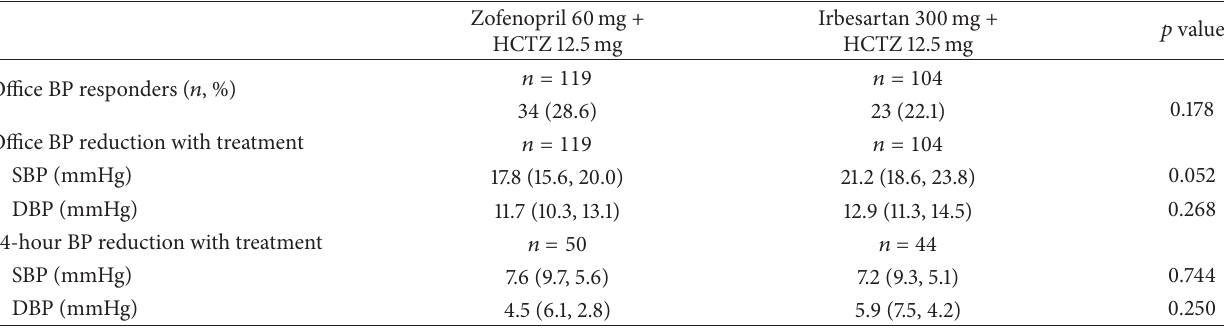
Table 4: Rate of office blood pressure (BP) responders ( < 140/90mmHg in nondiabetics and < 130/80mmHg in diabetics or high-risk patients, or SBP reduction ≥ 20 mmHg or DBP reduction ≥ 10mmHg) and baseline-adjusted office and 24-hour SBP and DBP reductions after 48 weeks of treatment with zofenopril 60 mg + hydrochlorothiazide (HCTZ) or irbesartan 300 mg + HCTZ. Data are shown for the intention-to-treat population and reported as absolute ( 𝑛 ) and relative (%) frequencies and as mean and 95% confidence interval. The 𝑝 value refers to the statistical significance of the intertreatment